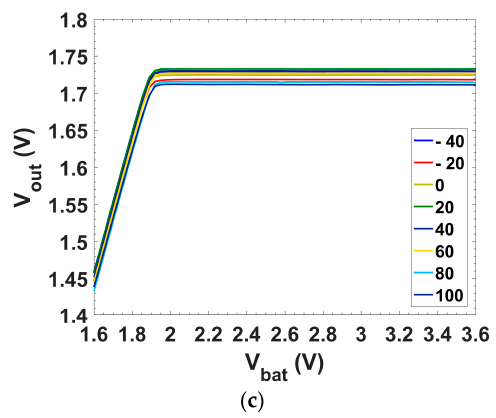
Figure 8. V in –V out characteristic: ( a ) oscilloscope caption at I L = 50 mA; ( b ) different current loads; and ( c ) different temperatures with maximum load current (50 mA).